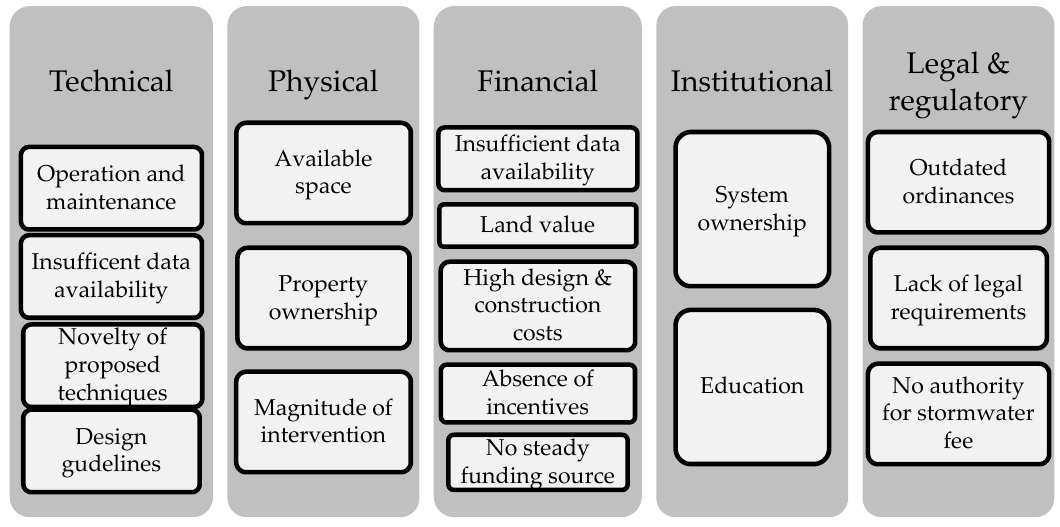
Figure 1. Barriers for the implementation of the Delay and Store parts of the RDSD, as identified by interviewees